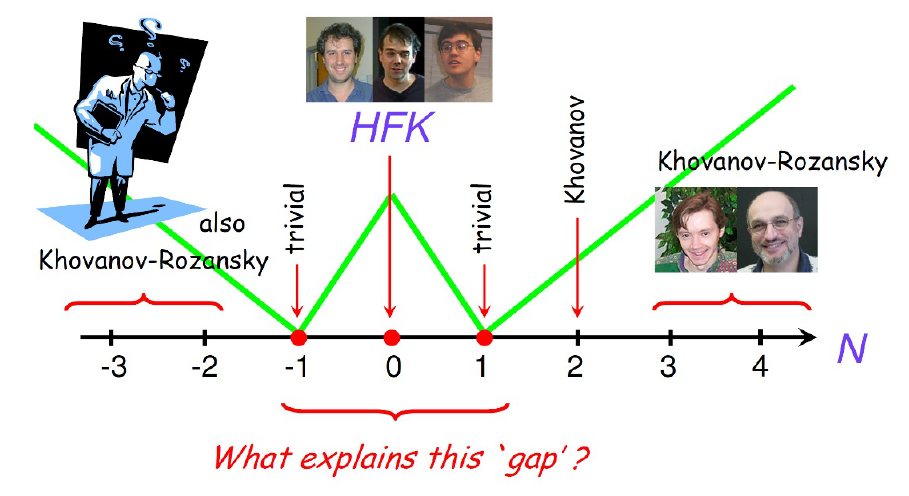
Figure 1 . The landscape of knot homologies shows peculiar behavior at N = (cid:0) 1 ; 0 and 1.